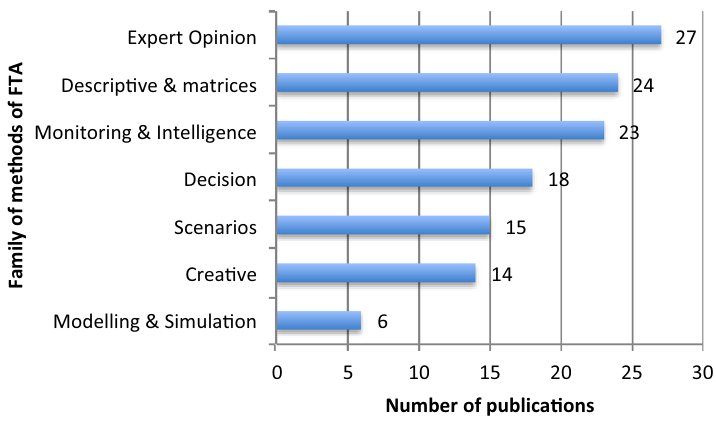
Fig. 1 Publications per family